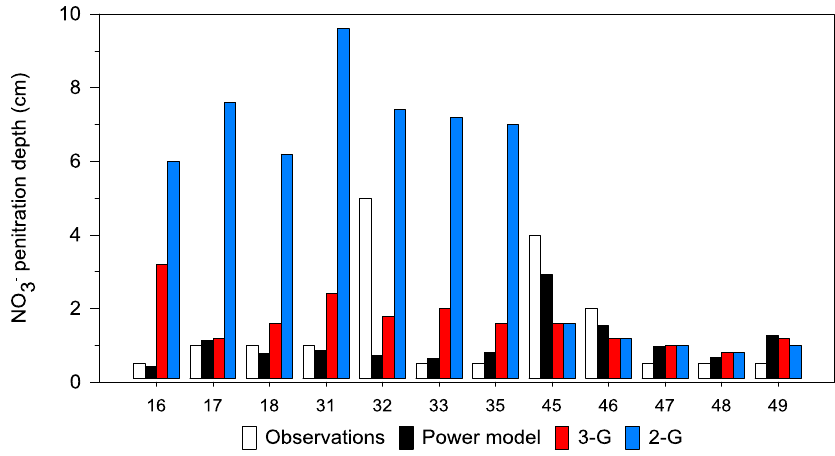
Figure 6. Observed and simulated nitrate penetration depths (NPD in cm) for sites compiled by Archer et al. (2002) that are independent to those in our database. The numbering on the x axis denotes the data set number given in Table 2 in Archer et al. (2002). The power model result is from Stolpovsky et al. (2015). To simulate the data, measured RRPOC and bottom water O 2 and NO − were used as boundary